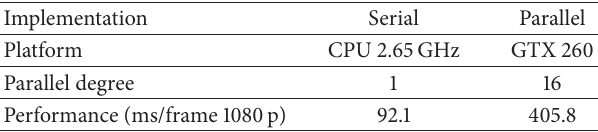
Figure 12: The filtering order for boundaries of a MB. Table 2: The performance comparison between nonoptimized parallel deblocking filter on GPU and serial one on